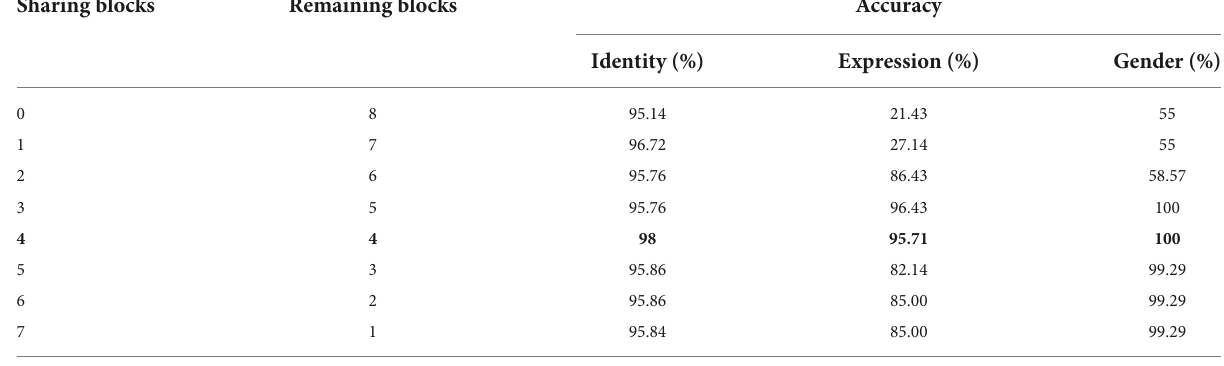
TABLE 2 Face classification performance of multi-task deep learning network (MTDLN) at varied architectures. Sharing